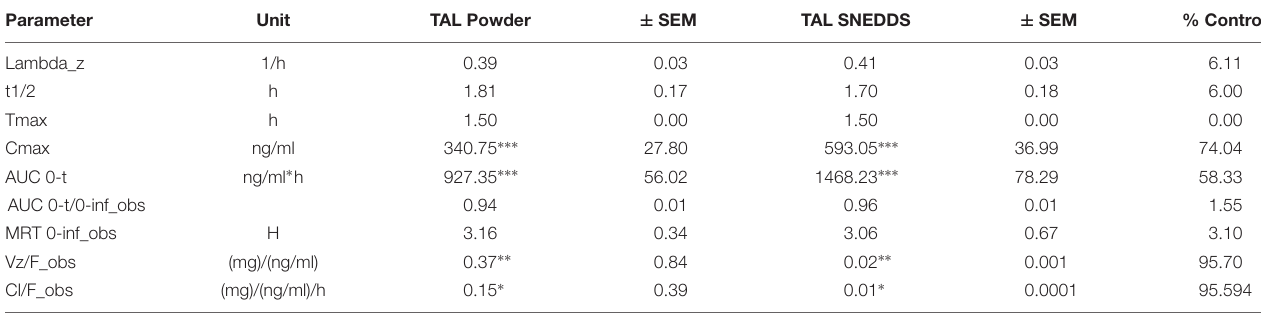
TABLE 4 | Comparison of pharmacokinetic parameters of TAL after oral administration of TAL powder and SNEDDS formulation [F6, I308: TC (1:1)/HCO-30 (1/1)] containing TAL.